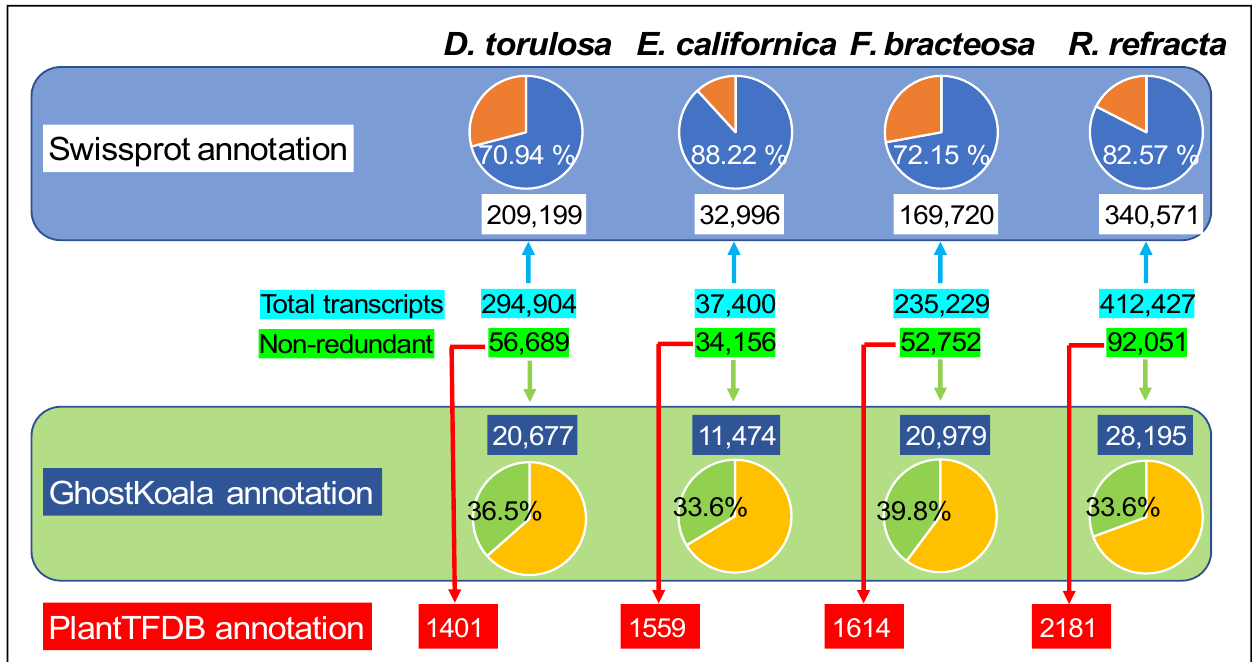
Figure 2. Summary of the number of functionally annotated transcripts for the four species studied, using the Swissprot, GhostKoala, and Plant Transcription Factor databases.